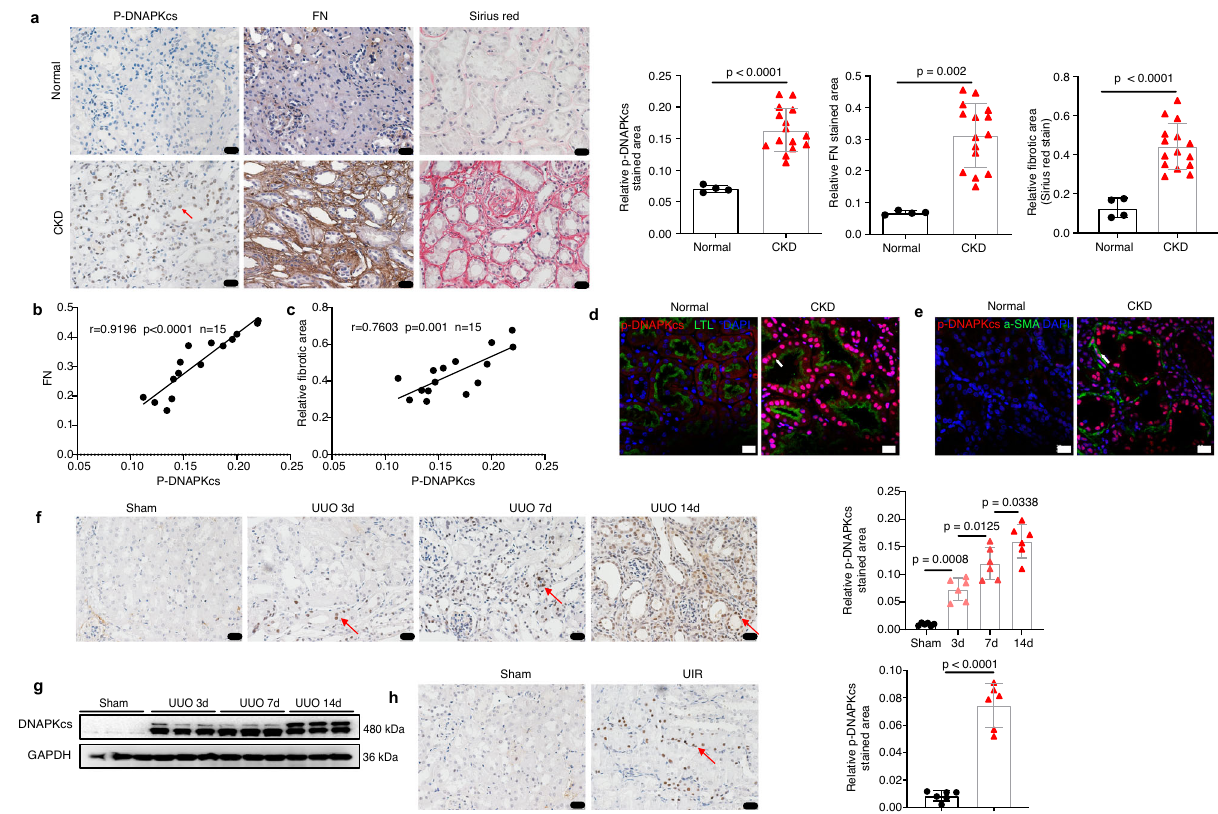
Fig. 1 | DNA-PKcs is increased in the kidneys of CKD patients and mice with kidney fi brosis.a Immunohistochemical staining ofp-DNA-PKcs (indicated by red arrow), FN and Sirius red staining in kidney tissues of normal ( n =4) and CKD ( n =15) patients, scale bars: 20 μ m. Bars represent quanti fi cation results and data are shown as the mean±SD. Two-tailed unpaired t-test was used to determine the p -values. b Pearson ’ s r correlation analysis between FN and p-DNA-PKcs protein levels in CKD patients ( n =15) with 95% con fi dence interval from 0.7701 to 0.9733. c Pearson ’ s r correlation analysis between collagens deposition (Sirius red) and p- DNA-PKcs proteinlevelsin CKDpatients ( n =15) with 95%con fi denceinterval from 0.4062 to 0.9159. d Immuno fl uorescence co-staining of p-DNA-PKcs with a renal tubulemarker,Lotustetragonolobuslectin(LTL)inkidneytissuesofnormal( n =4) andCKD( n =4)humanstudyparticipants,red:p-DNA-PKcs,green:LTL,bule:DAPI, scale bars: 20 μ m.Tubule isindicated byarrow. e Immuno fl uorescenceco-staining